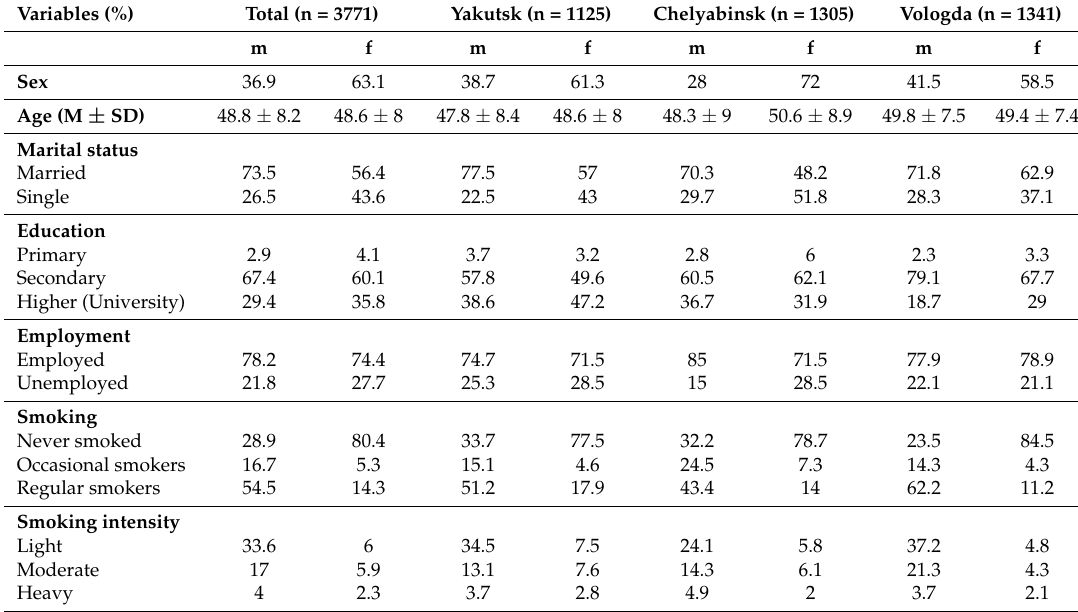
Table 1. Characteristics of the studied populations in the three different